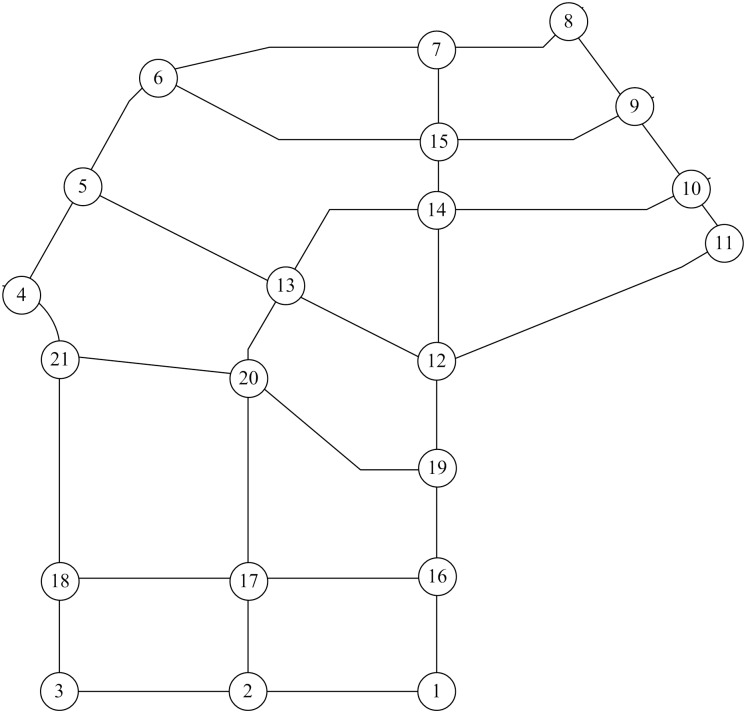
Sample road network.